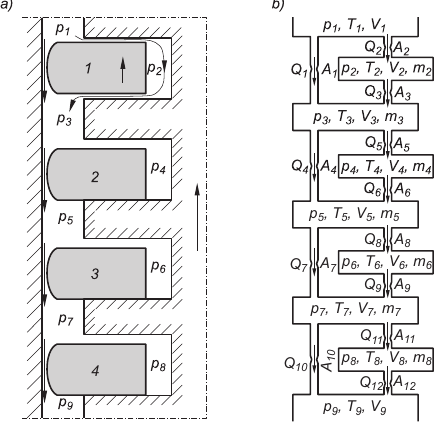
Fig. 1. Scheme of gas flow through the labyrinth seal of PRC system and the applied physical model for the ring pack of four piston rings It was also assumed that the gas flow through orifices is isentropic (depending on pressure ratio – subsonic or son- ic). The heat transfer between gas volume regions and sur- rounding walls was taken into